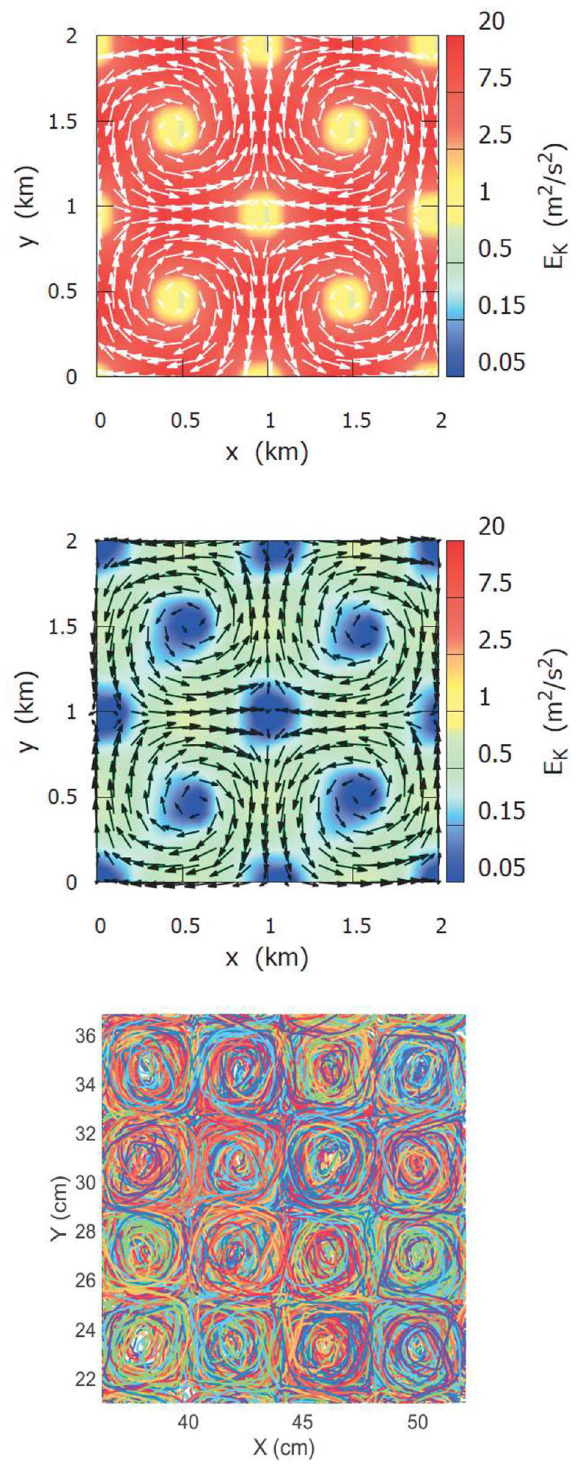
Figure 1. Mean kinematic velocity field, assimilated as input wind forcing with 10 m/s peak value (upper pannel) and mean hydrodynamic velocity field with 1 m/s peak value (center panel) of the Delft3D ∼ simulation. Bottom panel: Lagrangian trajectories obtained from laboratory